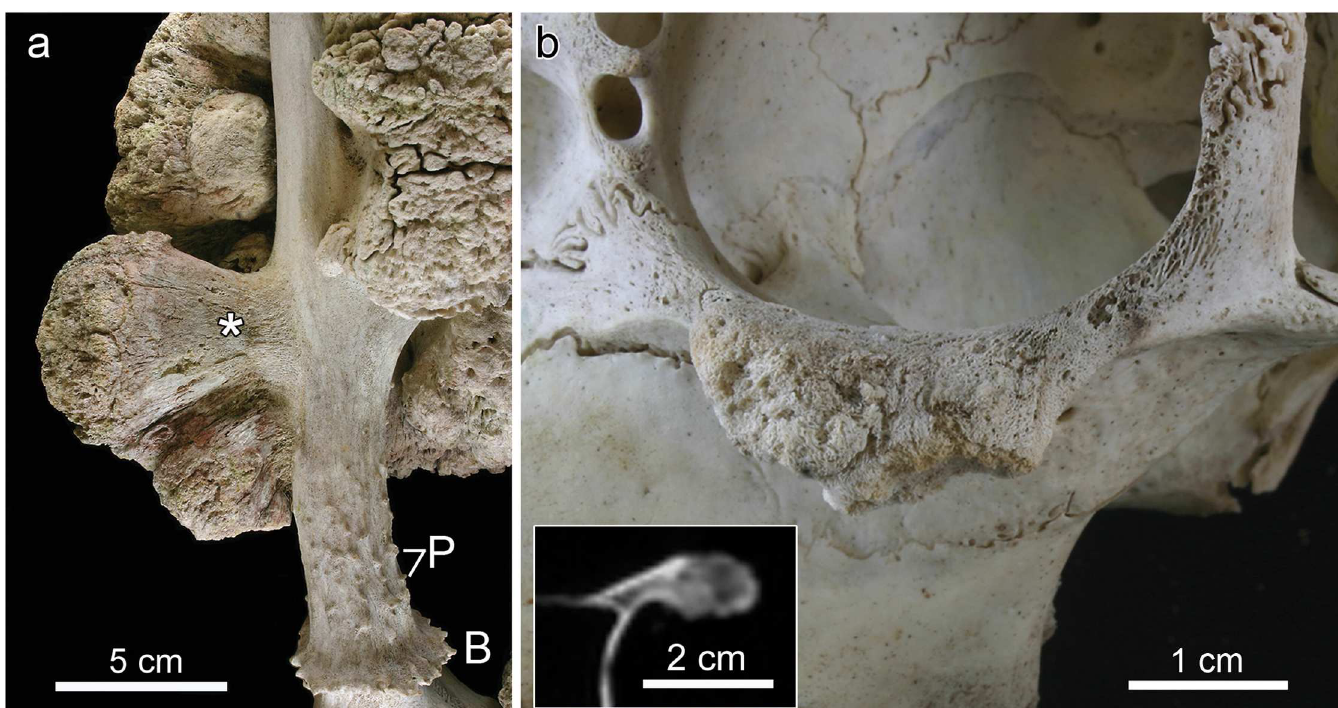
Fig 2. Close-up views of exostoses arising from the right antler (a) and the left zygomatic bone (b) of the white-tailed buck ( Odocoileus virginianus ). ( a ) Rostral view of the right antler showingthe smaller bilobularexostosis and portions of the more distally locatedlarger one. Note the smooth surface of the stalk (asterisk) and the rugose/nodularsurface of the peripheral portion of the mass. B: burr at antler base; P: small protuberances (‘pearls’) of the antler surface. ( b ) Lateral view of the left zygomatic bone with broad-basedexostosis. The insert shows a CT image demonstrating continuityof spongiosa and cortex of the exostosis with those of the parent